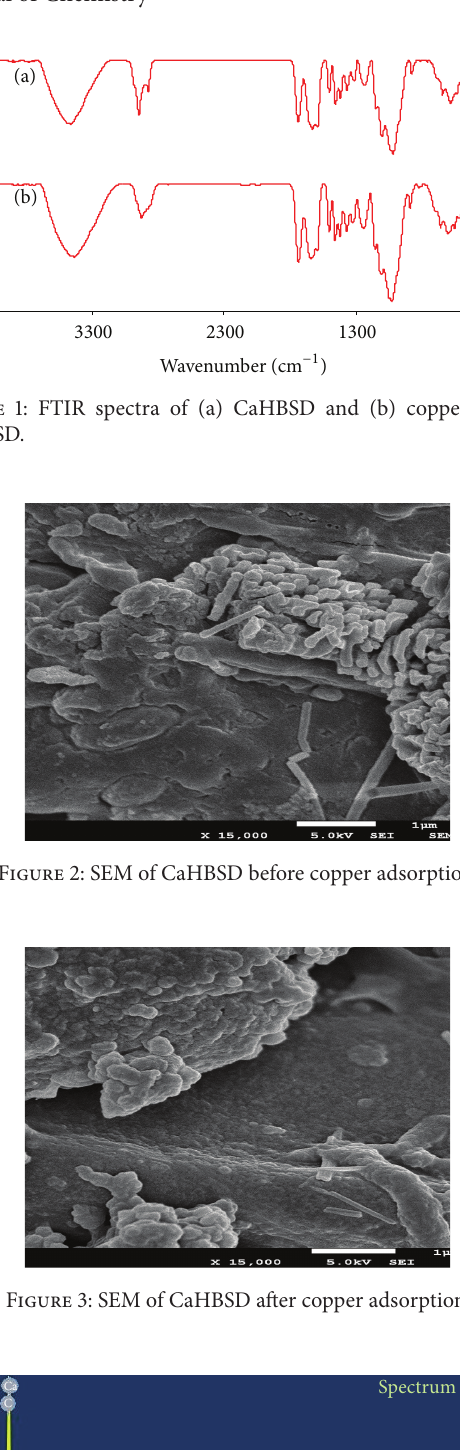
Figure 7: Effect of the contact time on the adsorption of copper by